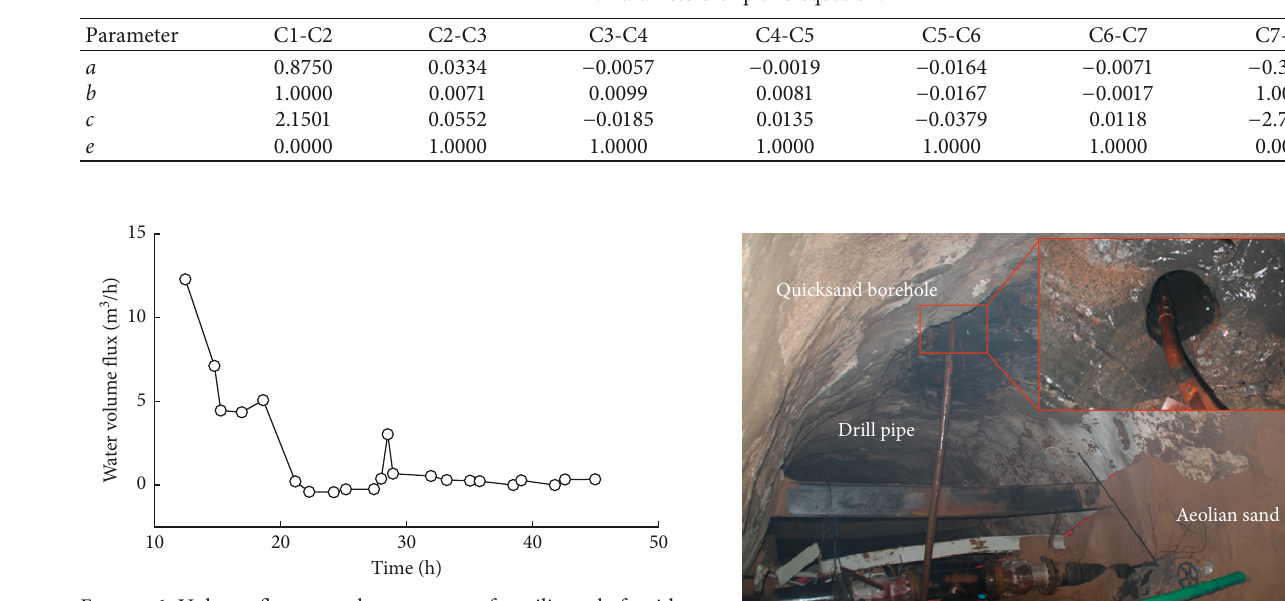
Figure 6: Volume flow rate change curve of auxiliary shaft with time in Longde coal mine. Figure 7: Borehole and chamber photo after quicksand disaster.